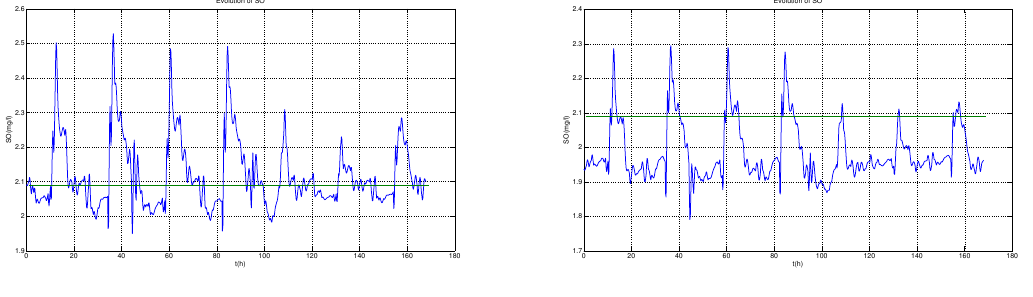
Figure 10. Evolution of S O 2 : (left) case 3; (right) case 4.